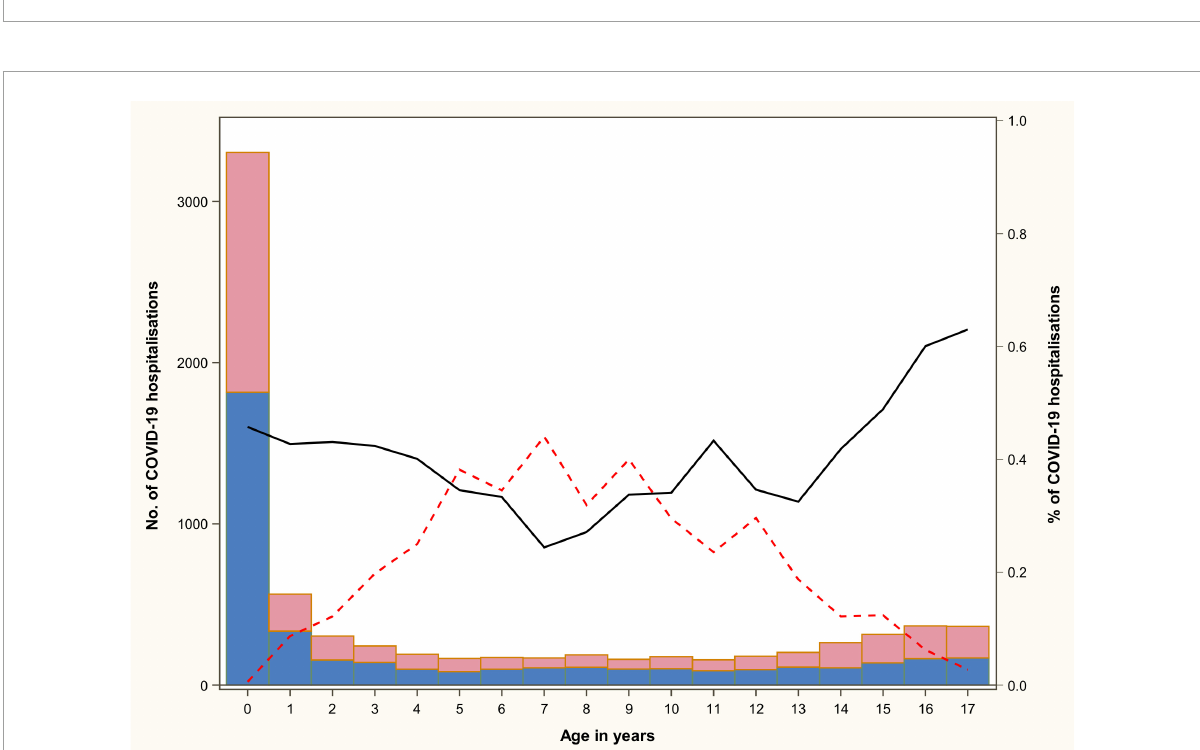
FIGURE1 Study patient selection flow chart.